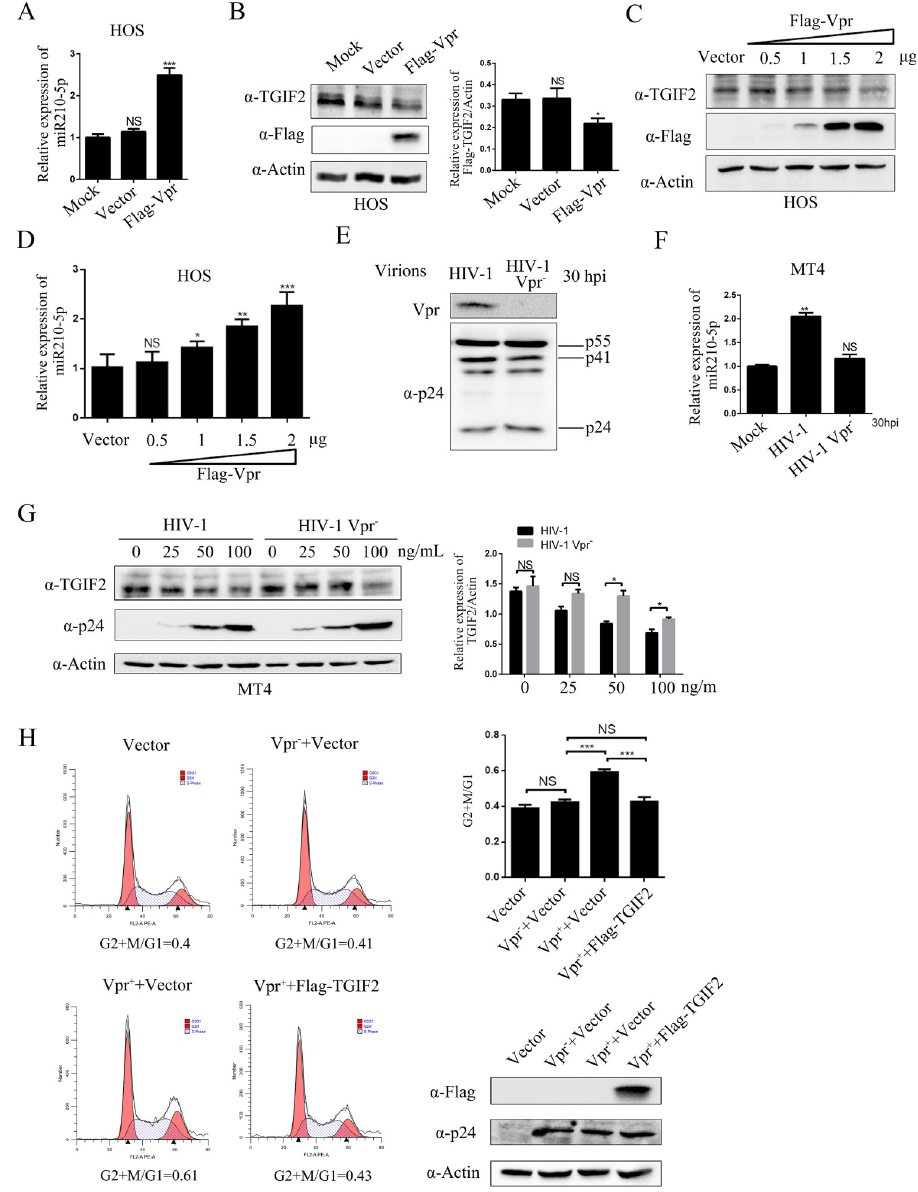
Fig 4. Effect of Vpr-induced TGIF2 downregulation on the cell cycle. (A-B) HOS cells were transfected with Flag- Vpr for 30 h. miR-210-5p and TGIF2 expression was determined by qPCR and western blot analysis, respectively. (C-D) HOS cells were transfected with Flag-Vpr for 30 h in 6-well cell plates. miR-210-5p and TGIF2 expression was determined by qPCR and western blot analysis, respectively. (E) pNL4-3.Luc.R+E- (containing the full-length vpr gene) or pNL4-3.Luc.R-E- (which cannot express Vpr protein) and VSV-G were transfected into HEK293T cells for 48 h. Virions collected from the culture media (using virus precipitation solution) were analyzed by western blot analysis with anti-Vpr antibody. (F) MT4 cells were inoculated with HIV-1 or HIV-1 Vpr- virus for 30 h, and miR-210-5p expression was detected by qPCR. (G) MT4 cells were inoculated with HIV-1 or HIV-1 Vpr - virus at various concentrations and TGIF2 expression was detected by western blot analysis. (H) HOS cells overexpressing TGIF2 were inoculated with HIV-1 or HIV-1 Vpr - virus for 48 h and the cell cycle was analyzed by flow cytometry. The percentages of G1 and G2+M cells were determined using ModFit software and the G2+M/G1 ratios were analyzed. Viral infection was confirmed by anti-p24 antibody detection. In all experiments, the relative Flag-TGIF2 or TGIF2 levels were estimated by densitometry; the ratios were calculated relative to the actin control. The data are presented as mean ± SD for three biological replicates, and statistical significance compared to the controls was calculated by t test. � P < 0.05, �� P < 0.01, ��� P < 0.001, NS: not